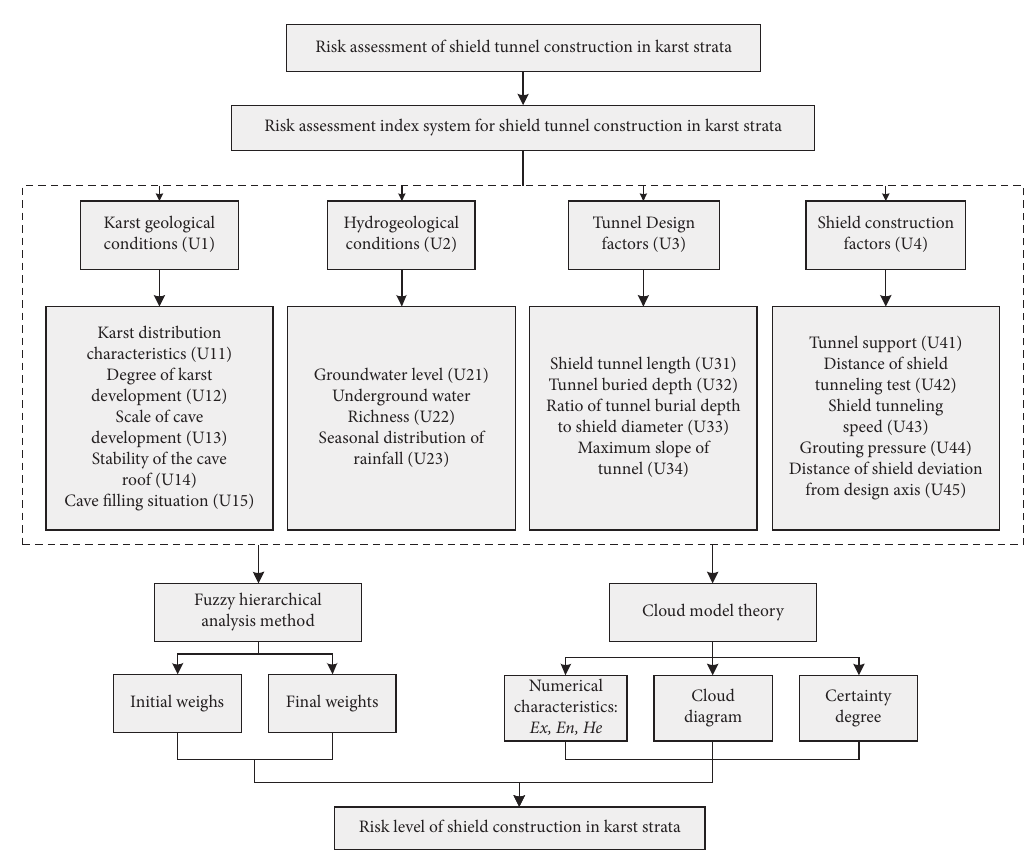
Figure 4: Risk assessment model based on FAHP-cloud